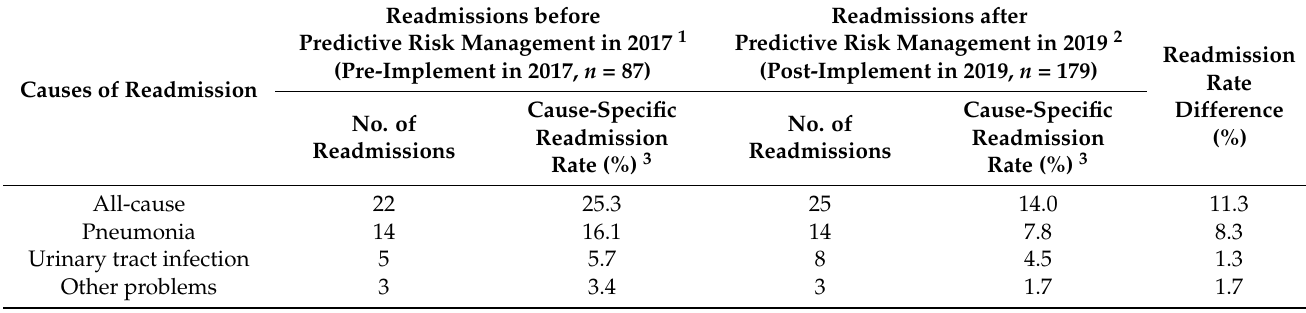
Table 2. 30-day readmissions and cause-specific readmission rates before (Pre-Implement) and after (Post-Implement) imple- menting LACE score-based predictive risk management tool to long-term home care patients of a medical center affiliated home care unit in Taiwan in 2017 and 2019. (Pre-Implement cohort in 2017, n = 87; Post-Implement cohort in 2019, n =